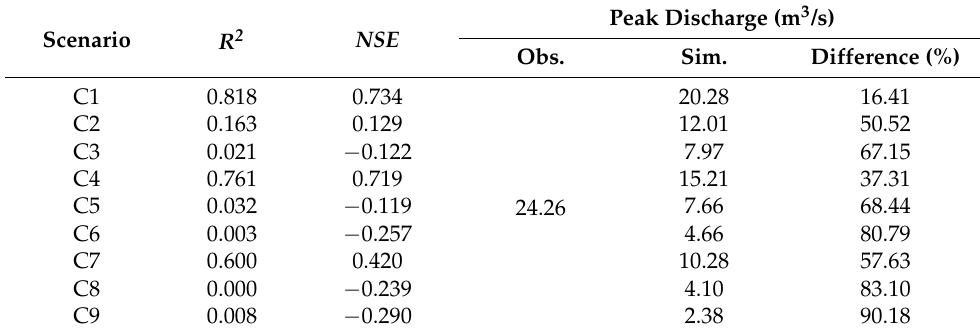
Table 5. Performance of discharge simulation over calibration processes.